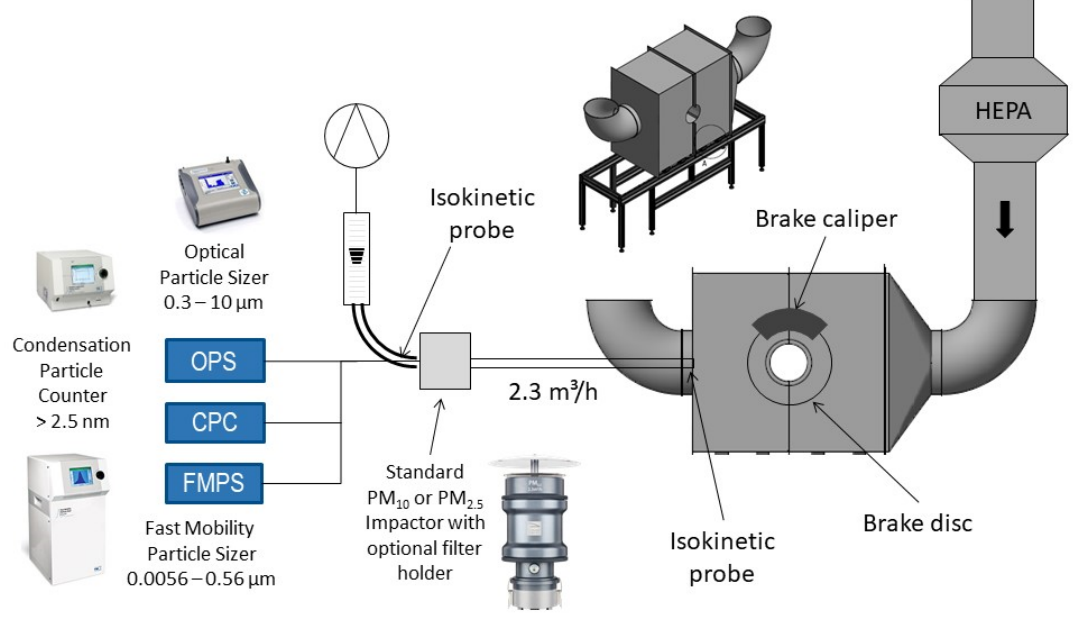
Figure 2. Experimental setup for the measurement of brake wear particles on a dynamometer [3].